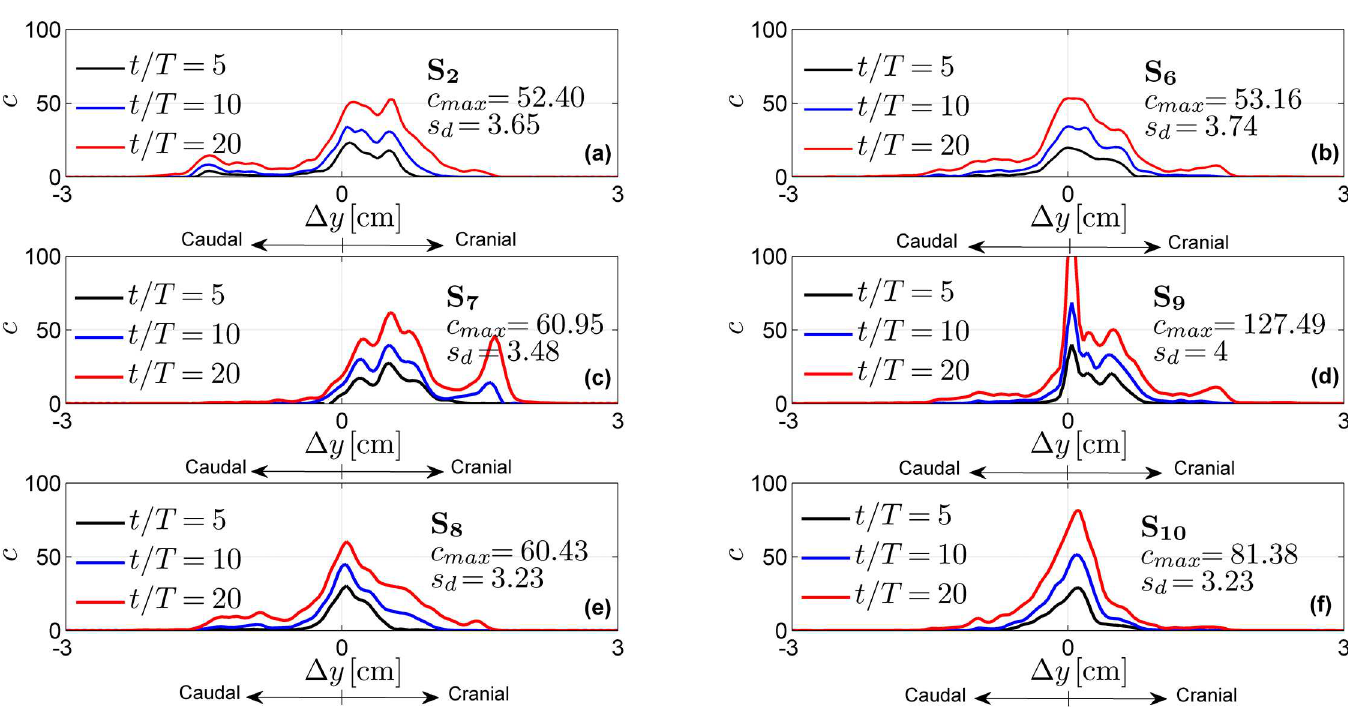
Fig 6. Normalized drug concentration profiles as a function of the distance Δ y from the injection point for different catheterangles. The profiles are obtainedwith a dorsal injectionlocated at P 2 (for test cases S 2 , S 7 , S 8 ) and with a lateral injectionlocatedat P 6 (for test cases S 6 , S 9 , S 10 ).